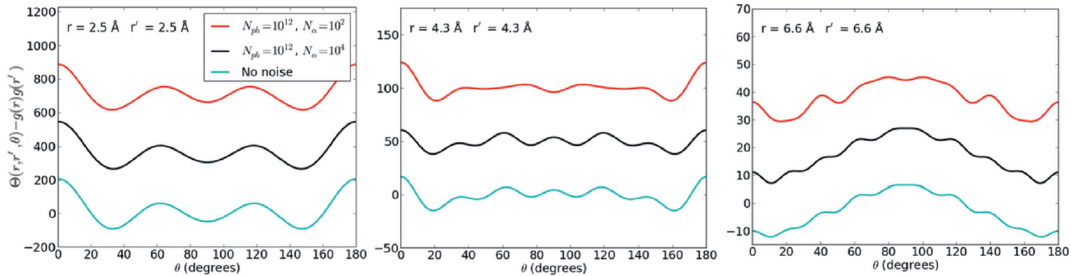
Figure 7 Angular distributions for amorphous nickel varying the number of patterns. The centrosymmetric filter has been applied to the intensity correlations. For ¼ 10 2 , noise significantly the alters the peak structure beyond the first-nearest-neighbour distance (>2.5 A˚ ). For N N (cid:3) with the noise-free calculation. The plots have been offset to aid